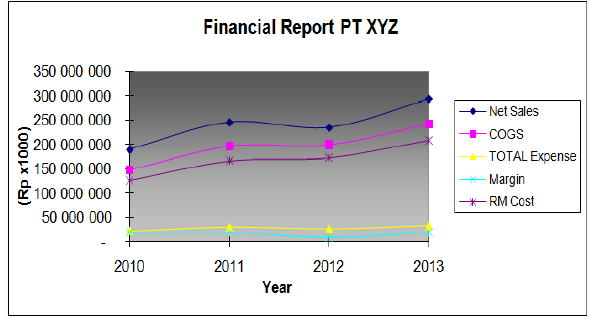
Fig. 4. Trend of company financial report